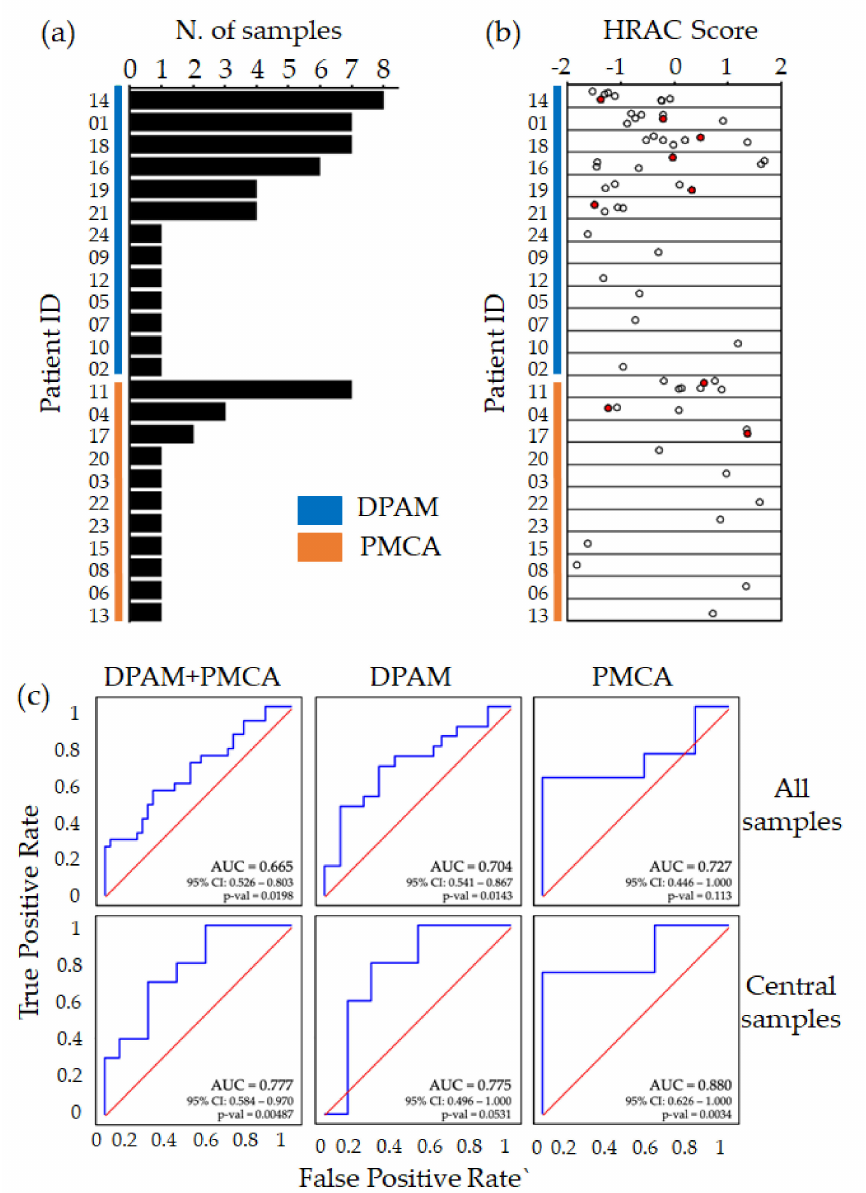
Figure 1. Prognostic performance of the transcriptional HRAC score. ( a ) Bar plot representing the cohort of 24 pseudomyxoma peritonei (PMP) patients in terms of number of samples per patient and pathological classification, with di ff use peritoneal adenomucinosis (DPAM) in blue and peritoneal mucinous carcinomatosis (PMCA) in orange; ( b ) high-risk appendiceal cancer (HRAC) score calculated in each sample subdivided by patient of origin. Red dots represent the central sample for patients with multiple profiles; ( c ) receiver operating characteristic (ROC) curves on disease-free survival (DFS) for HRAC in the full dataset (DPAM + PMCA), DPAM, and PMCA (DFS event = relapse within 24 months). For patients with multiple profiles, curves in the top row include all samples as if they were from di ff erent patients, while curves in the bottom row only include central